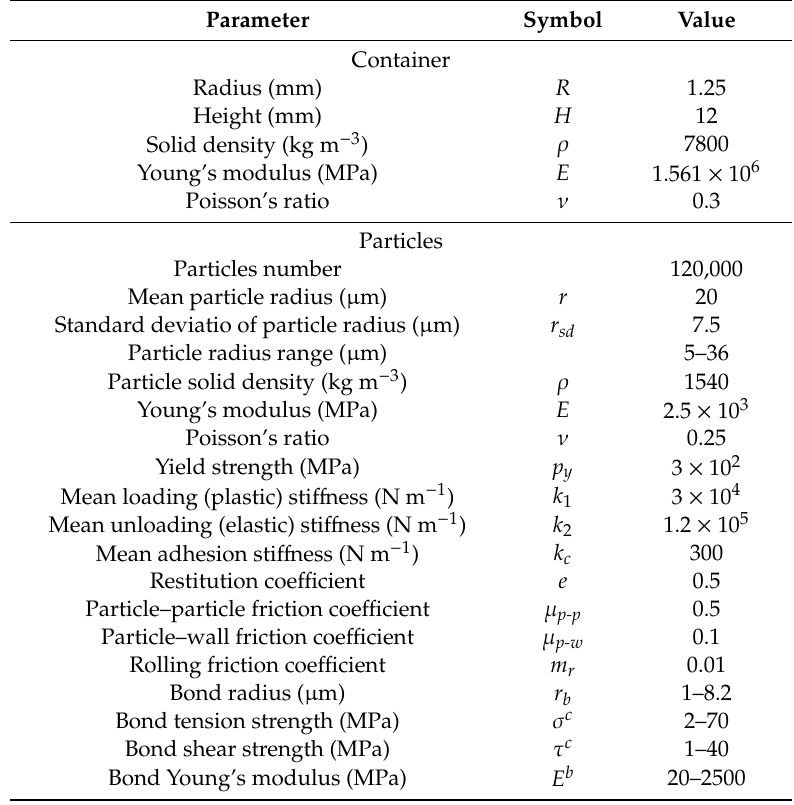
Table 1. Discrete element method (DEM) simulations